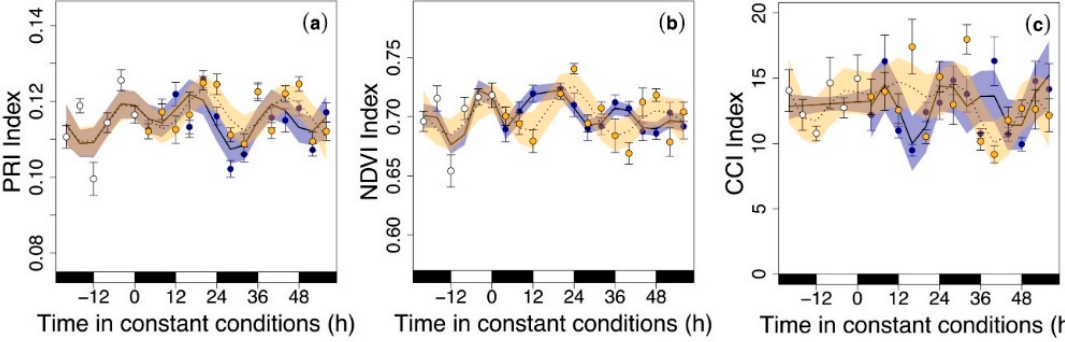
Figure 5. Optical indices in rocket leaves during the last cycle of the entrainment phase (white circles) and under continuous darkness (blue circles) and continuous illumination conditions light (yellow circles): ( a ) the photochemical reflectance index (PRI Index), ( b ) the normalized difference vegetation index (NDVI Index), and ( c ) the chlorophyll content index (CCI Index). Black and white rectangles on the x -axis represent subjective night and day, respectively (that is, when leaves would have experienced nighttime or daytime conditions). Time zero represents the time when constant conditions started. Temporal patterns were examined with the generalized additive model (GAM) fitted with automated smoothness selection [31]. Shaded areas indicate the 95% CI of the fitted GAM. Values are the mean of 16 replicates ± S.E.